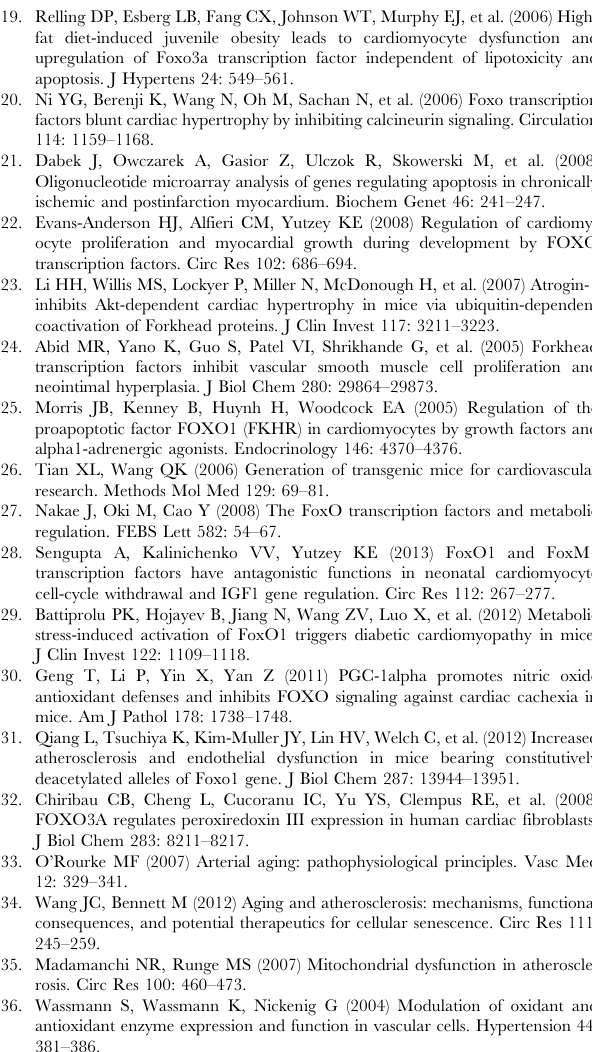
Table S1 Frequencies of FoxO1 and FoxO3 polymorphisms in two populations according to different genders. Table S2 Frequencies of FoxO1 and FoxO3 polymorphisms in two populations according to smoking or not. Table S3 Frequencies of FoxO1 and FoxO3 polymorphisms in two populations according to hypertension or not.